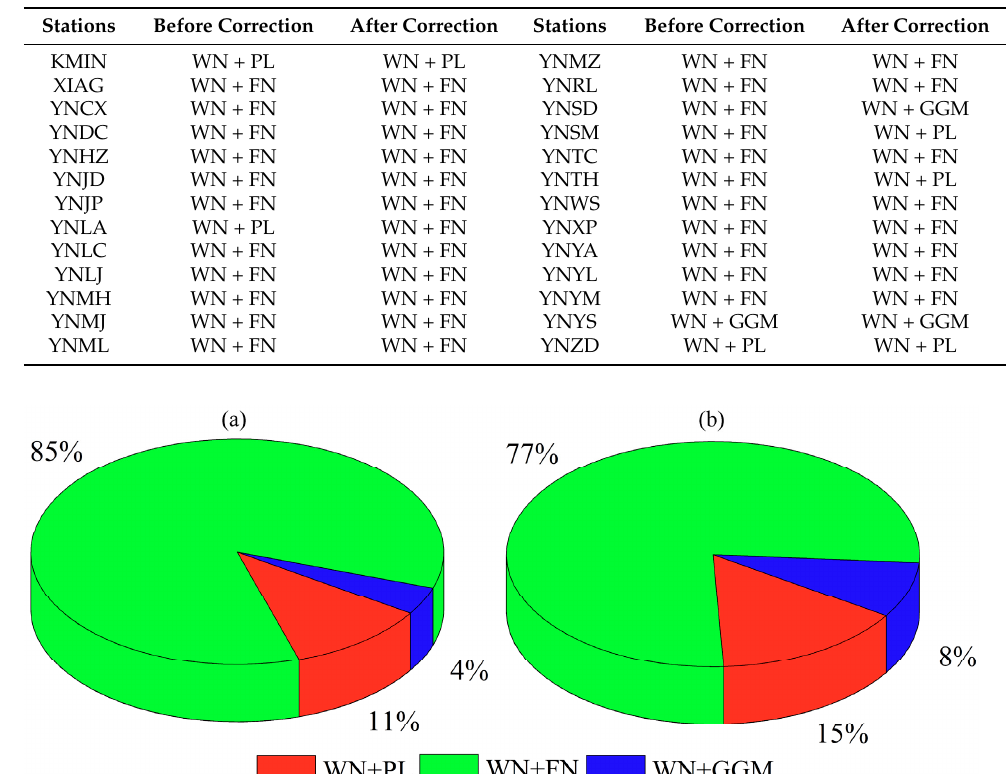
Table 3. The optimal noise model estimated from vertical GPS time series before and after